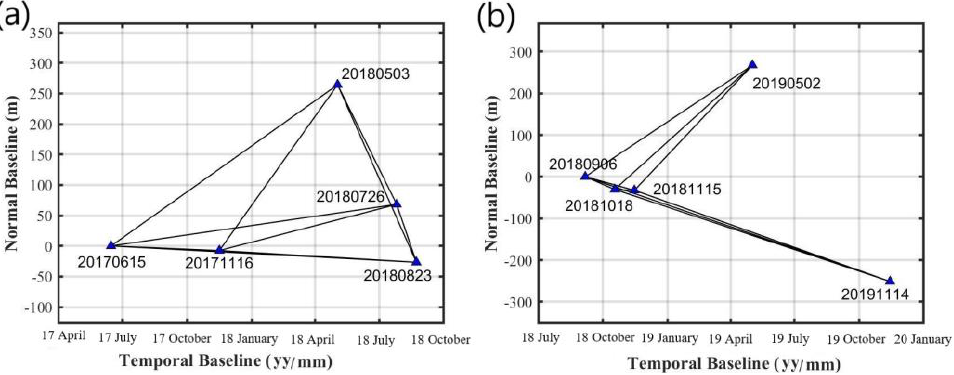
Figure 3. Temporal and spatial baselines of SAR datasets. ( a ) The spatiotemporal baseline combina- tion of pre-earthquake interference pairs. ( b ) The spatiotemporal baseline combination of interference pairs after the earthquake.